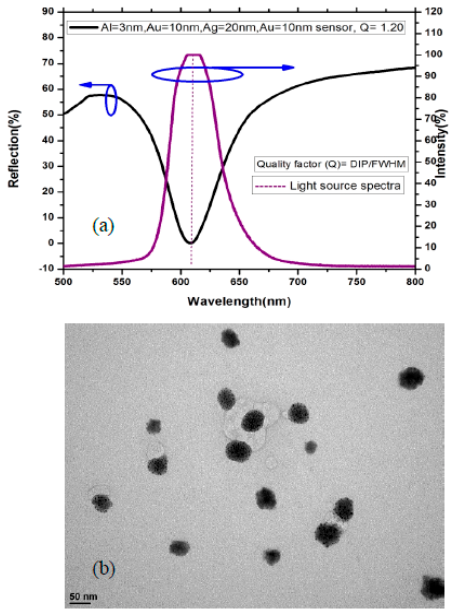
Figure 2. ( a ) Simulation results of novel four layer SPR sensing in this experiment; ( b ) TEM image of EV71 viral particle, after dropcast and washing protocol.